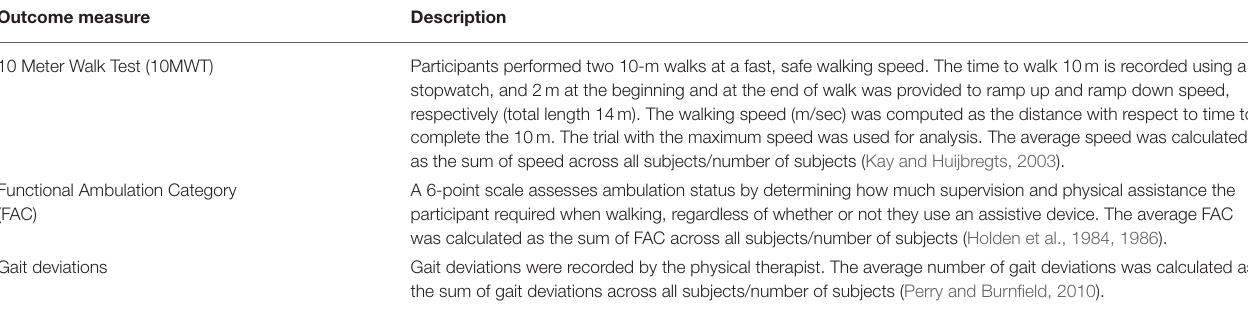
TABLE 2 | Primary outcome measures ( n =